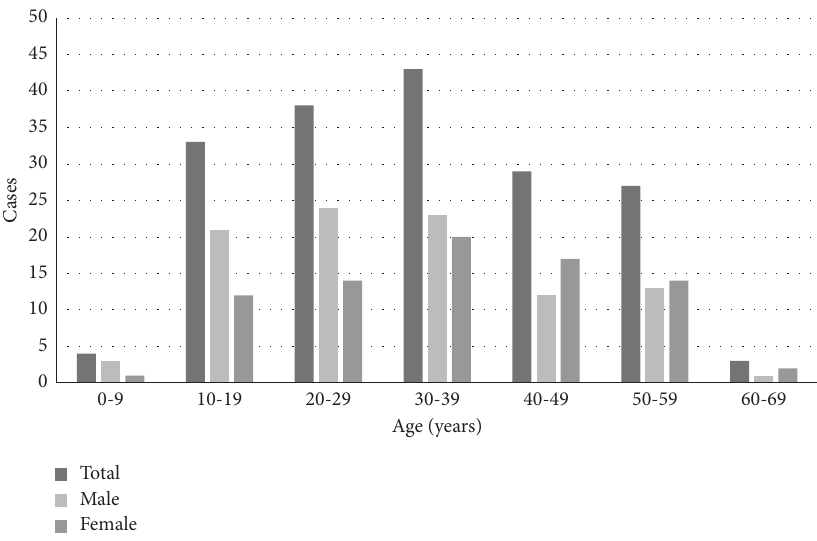
Figure 1: Distribution of patients’ age at PSC diagnosis according to sex ( n � 177).